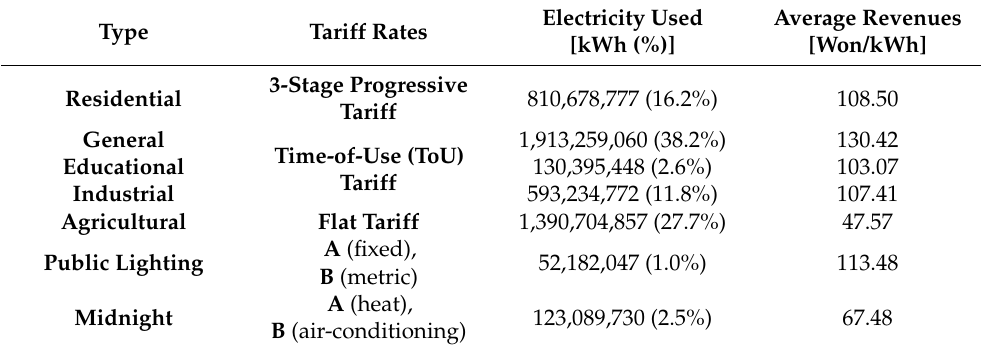
Table 3. Tariff rates, electricity used, average revenues by type of contract in Jeju 2017.